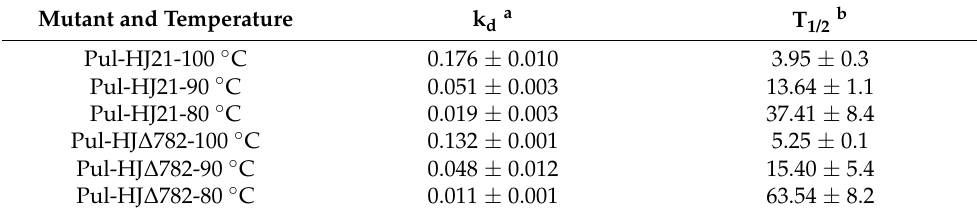
Figure 3. Temperature properties of Pul-HJ21 and Pul-HJ Δ 782. ( a ) Optimum temperature of Pul-HJ21; ( b ) optimum temperature of Pul-HJ Δ 782; ( c ) temperature stability of Pul-HJ21 based on the sum of α -amylase and pullulanase activities; ( d ) temperature stability of Pul-HJ Δ 782 based on the sum of α -amylase and pullulanase activities. Table 2. Half-life of Pul-HJ21 and Pul-HJ ∆